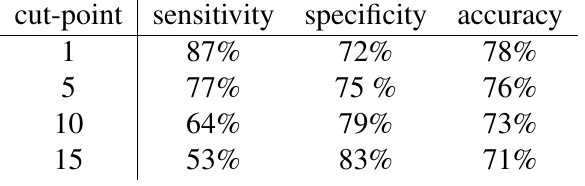
Figure 2: Plot of Area Under the ROC Curve (AUC) to discriminate coding regions using the inter-STOP distance and the chi-square statistic. Table 3: Sensibility, specificity and accuracy mean values for four cut-point values over all used files, not using the adjusted